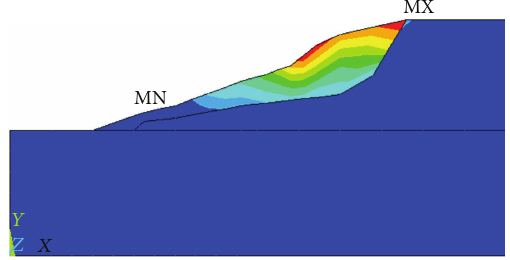
Figure 9: Scattergram of the equivalent plastic strain of the QC10 section.